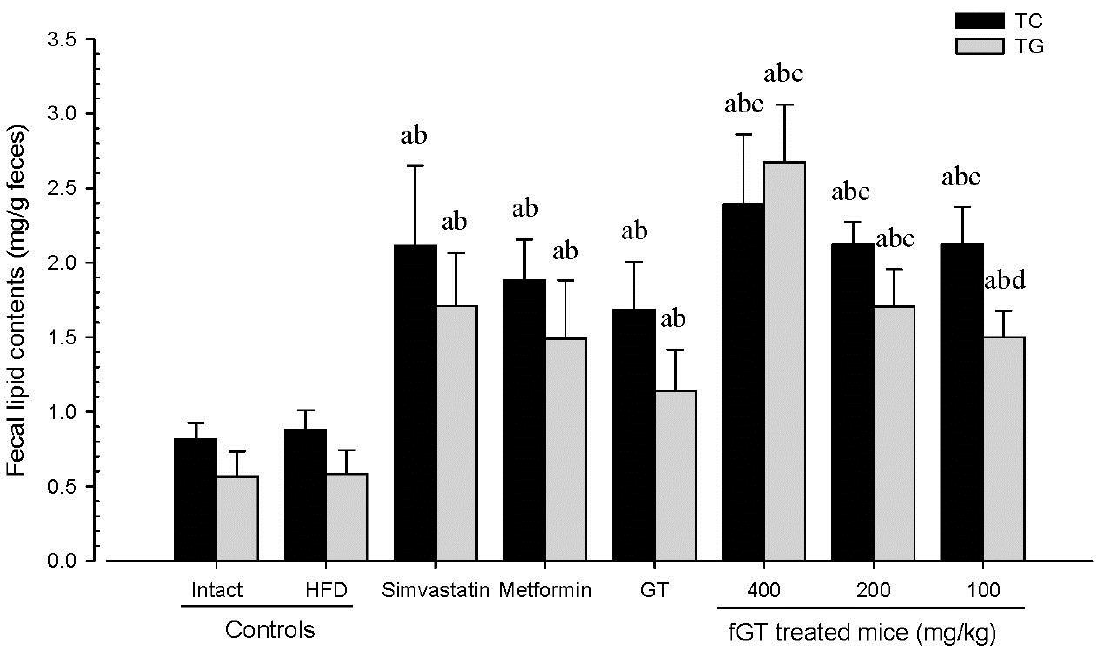
Figure 7. Fecal TC and TG content in NFD or HFD supplied mice. Values are expressed mean ± SD of eight mice. NFD, normal fat pellet diet; HFD, high fat diet; GT, green tea extracts; fGT, Aquilariae lignum -fermented green tea extracts; TC, total cholesterol; TG, triglyceride; GT was administrated at a dose level of 400 mg/kg. Simvastatin and metformin were administrated at dose levels of 10 and 250 mg/kg, respectively. a p < 0.01 as compared with intact control; b p < 0.01 as compared with HFD